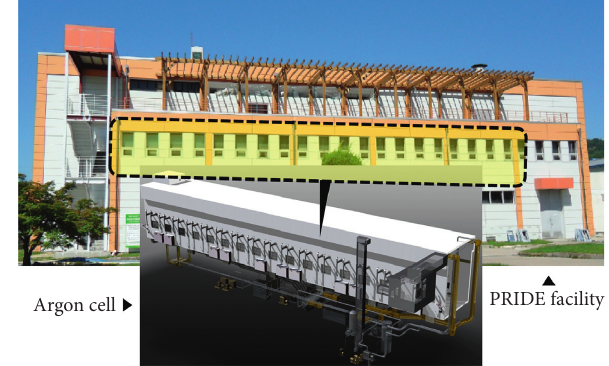
Figure 1: Isometric view of argon cell of PRIDE facility.